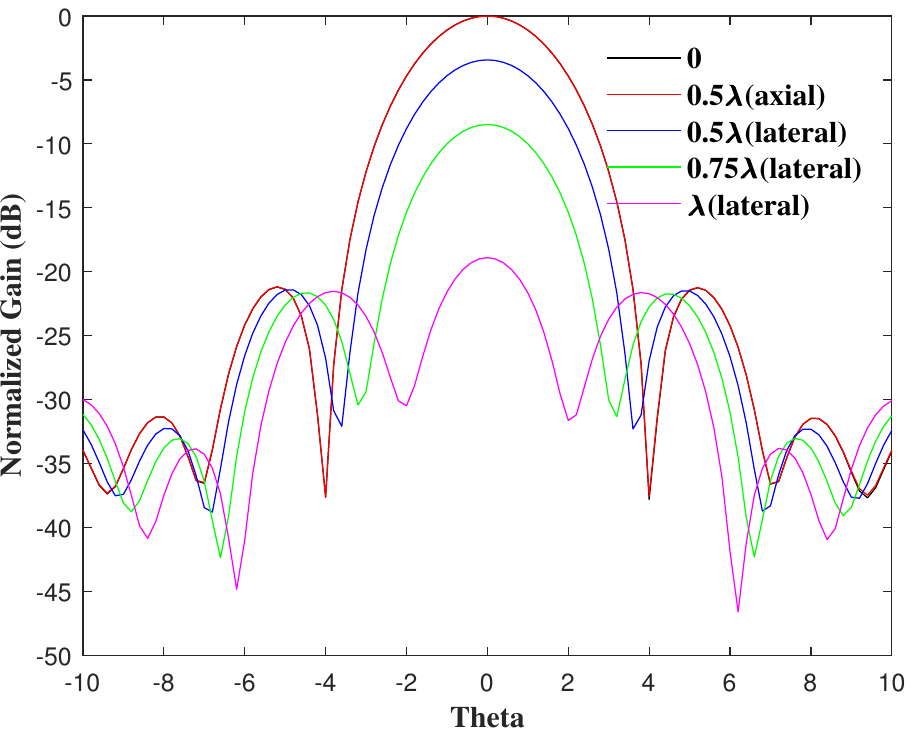
Figure 10. F / D = 0.75, far-field pattern of d = 0,0.5 λ (aixal), 0.5 λ (lateral), 0.75 λ (lateral) and λ